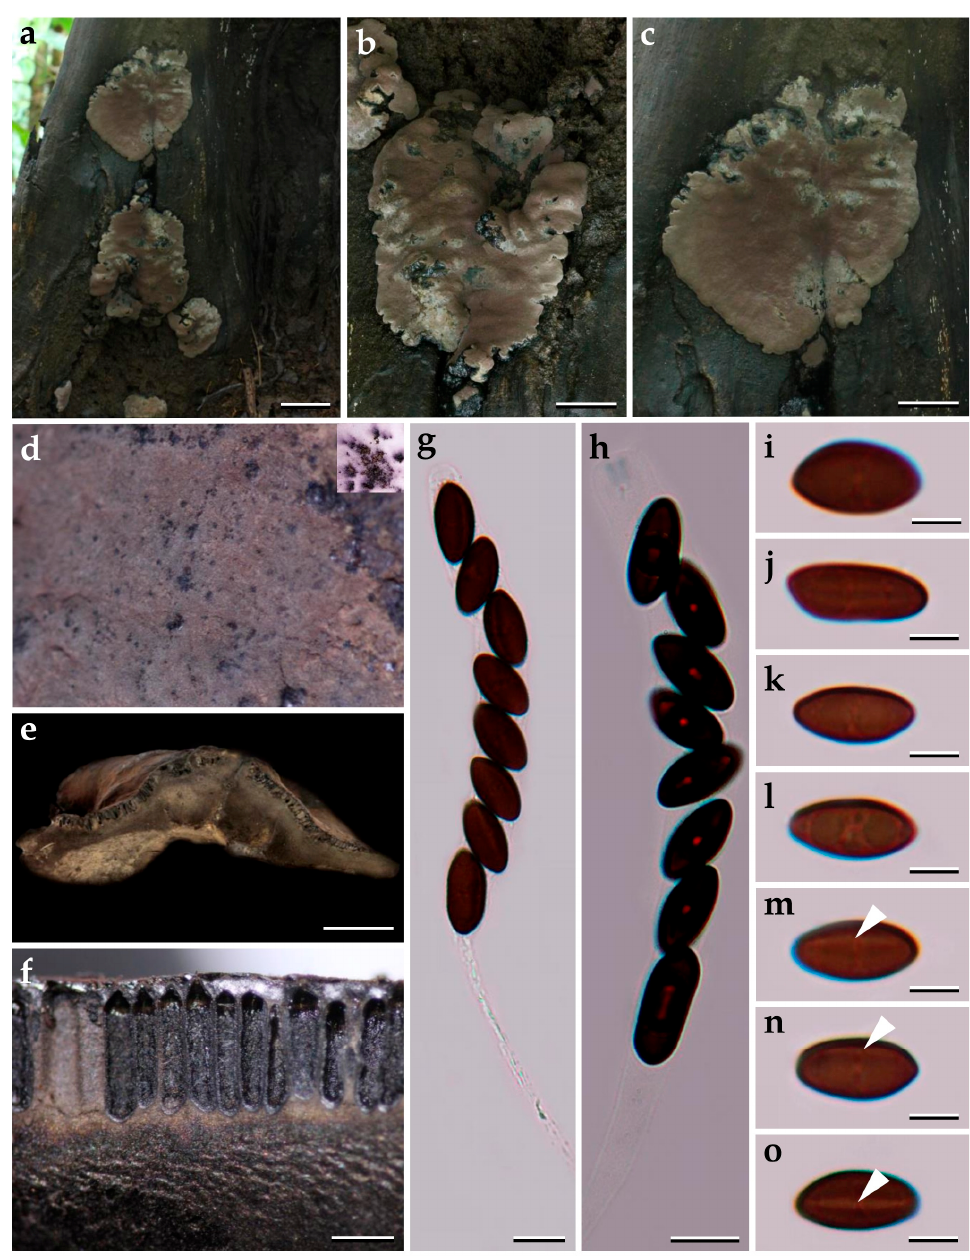
Figure 8. Morphological characteristics of Pyrenopolyporus macrosporus ( BBH47924). ( a – c ) Stroma on natural habit; ( d ) stromal surface and ostioles with KOH-extractable pigments in 10% KOH; ( e ) longitudinal section of stroma showing the tissue below the perithecial layer; ( f ) Perithecia; ( g ) ascus in distilled water; ( h ) ascus in Melzer’s reagent showing apical apparatus; ( j – o ) ascospores with highly variable shapes. Scale bars: ( a ) = 2 cm; ( b , c ) = 1 cm; ( e , f ) = 0.5 mm; ( g , h ) = 10 µm; ( i – o ) = 5 µm.